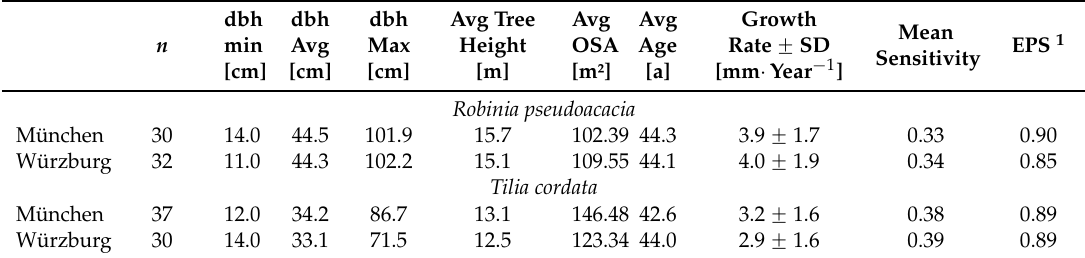
Table 1. Statistical characteristics of the tree ring series of Tilia cordata and Robinia pseudoacacia in München and